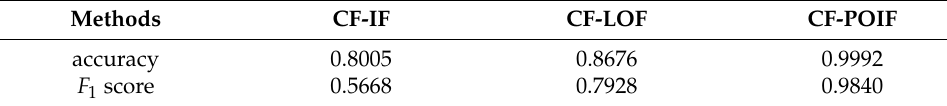
Figure 16. Abnormal data detection results of fan end signal. ( a ) CF-POIF; ( b ) CF-IF; ( c ) CF-LOF.